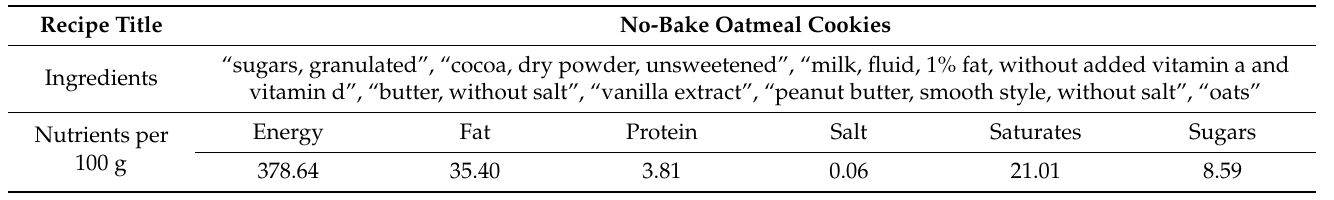
Table 1. Example instance from the Recipe1M